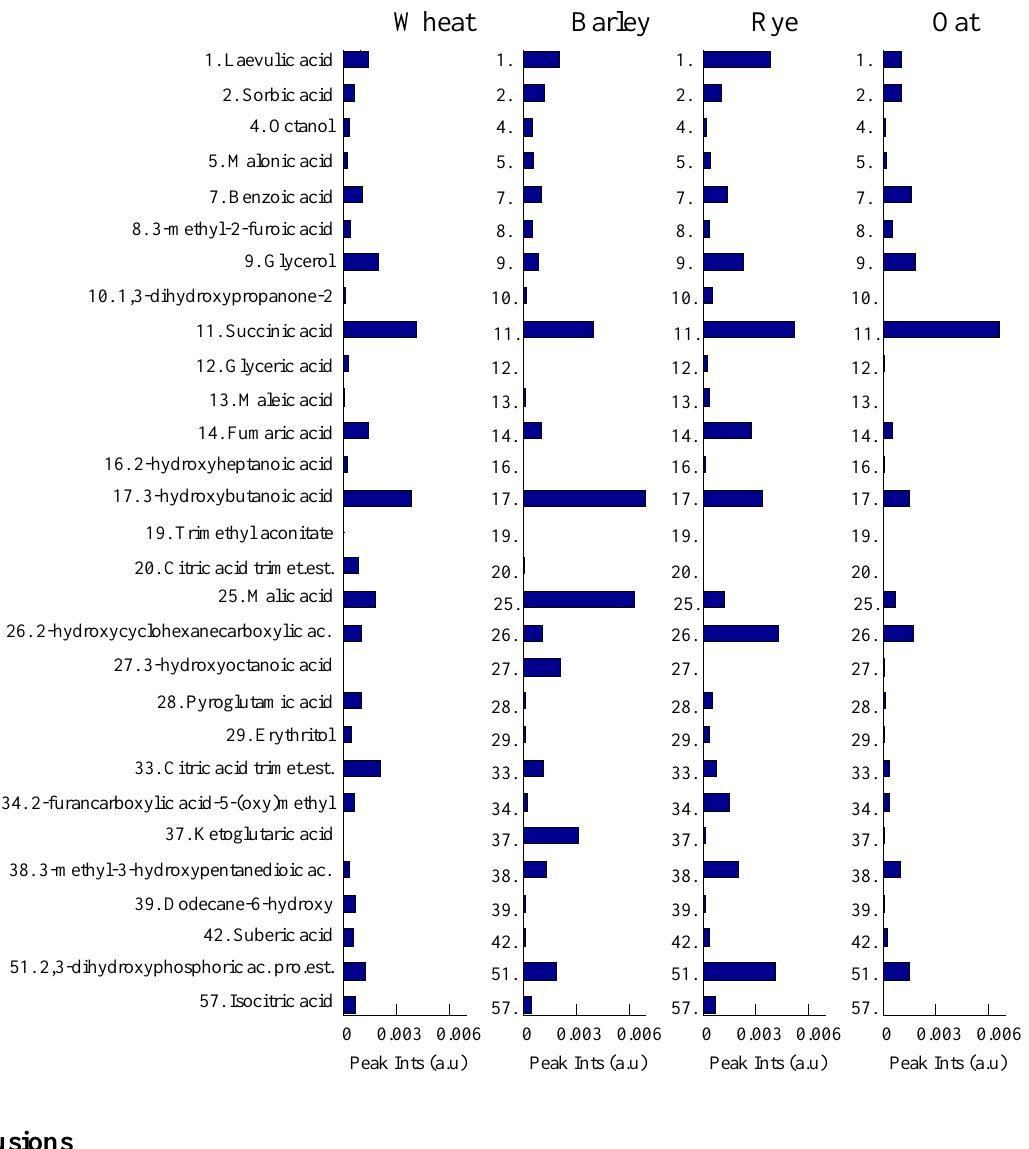
Figure 6. Relative concentrations of 29 organic acids/alcohols detected from wheat, barley, rye and oat. Metabolites are numbered according to the Table